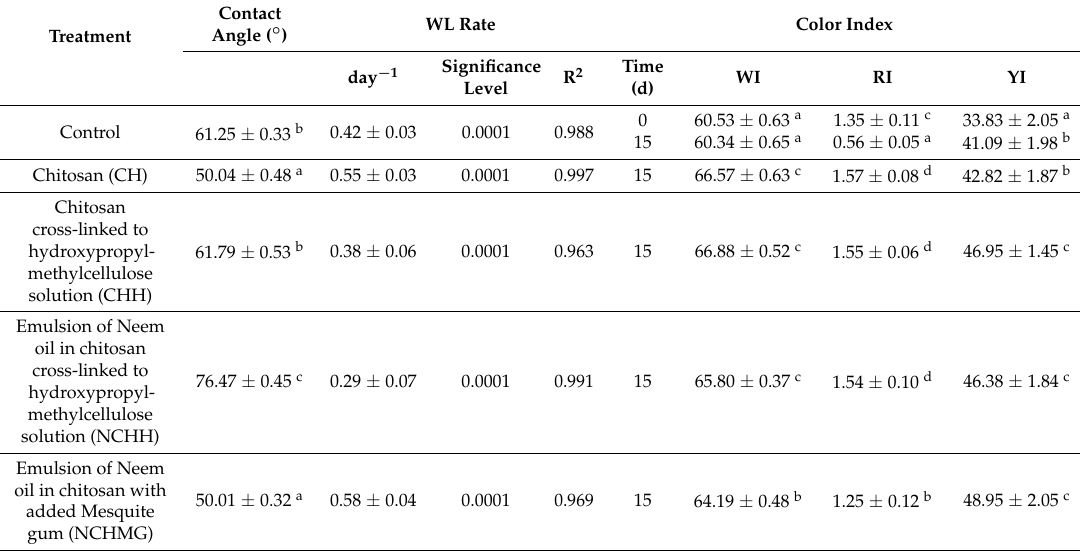
Table 2. Weight loss (WL) rate, contact angle, whiteness index (WI), redness index (RI), and yellowness index (YI) of epicarp of control and coated pitayas during storage at 10 ◦ C with relative humidity (RH) of